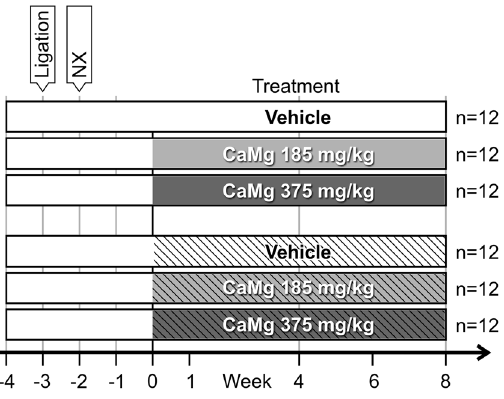
Figure 1. Setup of the study addressing the effect of calcium acetate/magnesium carbonate (CaMg) on bone. The three groups presented in the clear bars received a normal phosphorus diet; those presented in the hatched bars received a high phoshorus diet. Nx: 5/6 th nephrectomy.